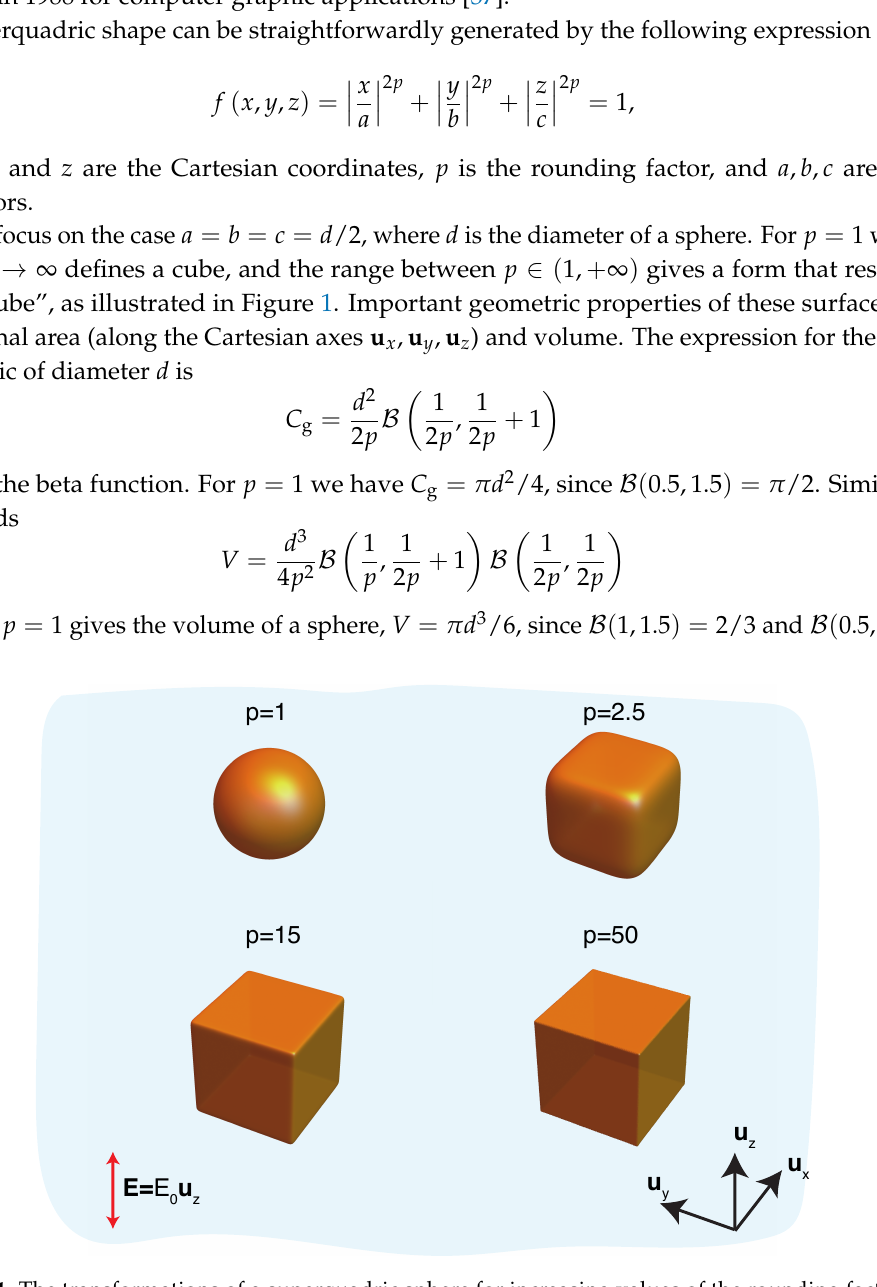
Figure 1. The transformations of a superquadric sphere for increasing values of the rounding factor p . The bottom left and bottom right cases depict the studies cases used in this work: a “smooth” p = 15 and a “sharp” p = 50 cube. The figure indicates a constant z -directed electrostatic excitation E = E 0 u z